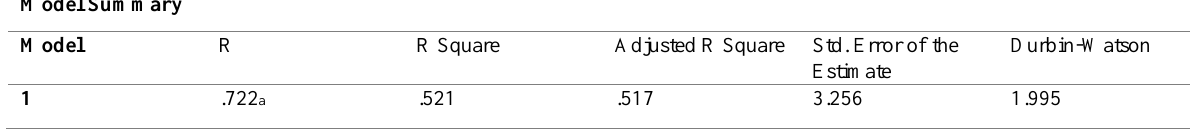
Table 4: Model Summary and